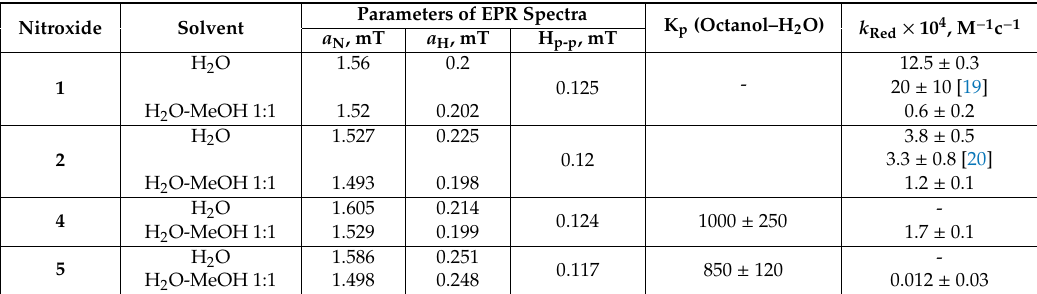
Table 1. Parameters of EPR spectra, octanol–water partition coe ffi cients (K p ), and rate constants of reduction with ascorbate for nitroxides 1 , 2 , 4 , and 5 (for details, see the experimental part).